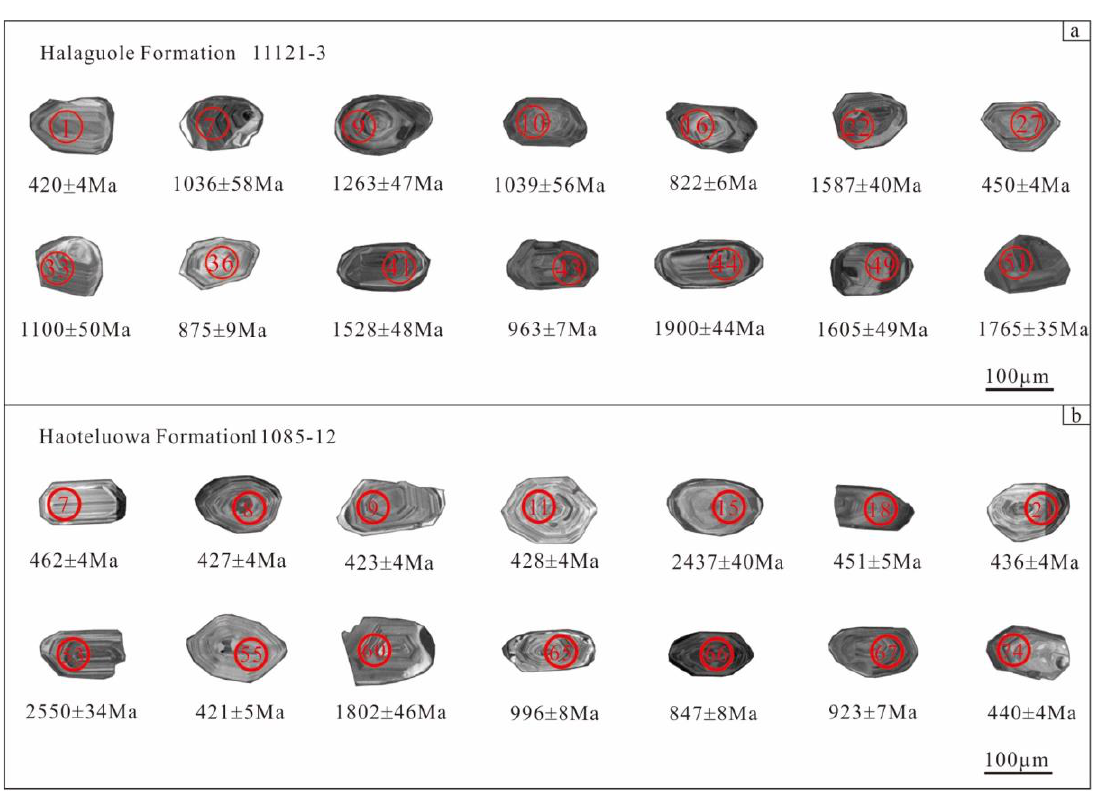
Figure 5. Typical CL images of detrital zircons from the Halaguole and Haoteluowa formations, EKO. The circles on zircons show the locations of U – Pb dating.